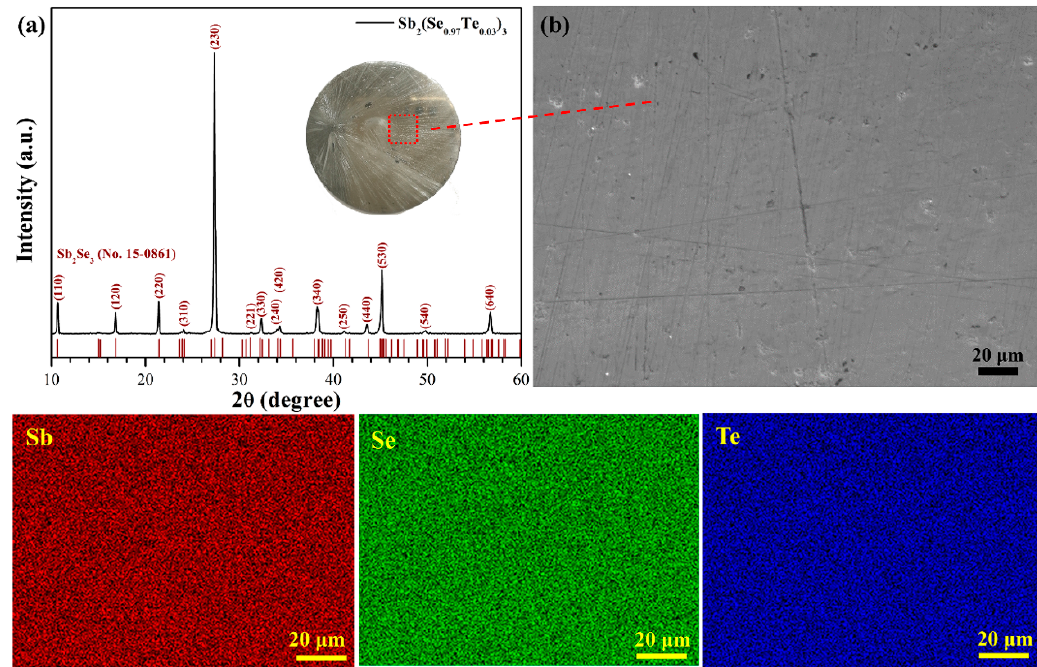
Figure 1. ( a ) The x-ray diffraction (XRD) pattern of the Te-Sb 2 Se 3 target prepared by the melting method. The inset is the surface morphology. ( b ) Scanning electron microscope (SEM) image and energy dispersive spectroscopy (EDS) elemental mapping of Sb, Se, and Te. Table 1. The energy dispersive spectroscopy (EDS) results of the Te-Sb 2 Se 3 targets prepared by the melting method in a vacuum (average composition).